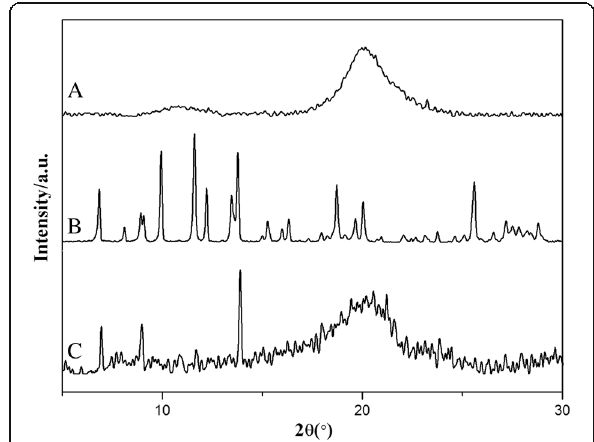
Fig. 7 In vitro drug release profiles of the MHNDs in PBS (pH 7.4) at 37 °C. ( a ) Free HCPT; ( b )